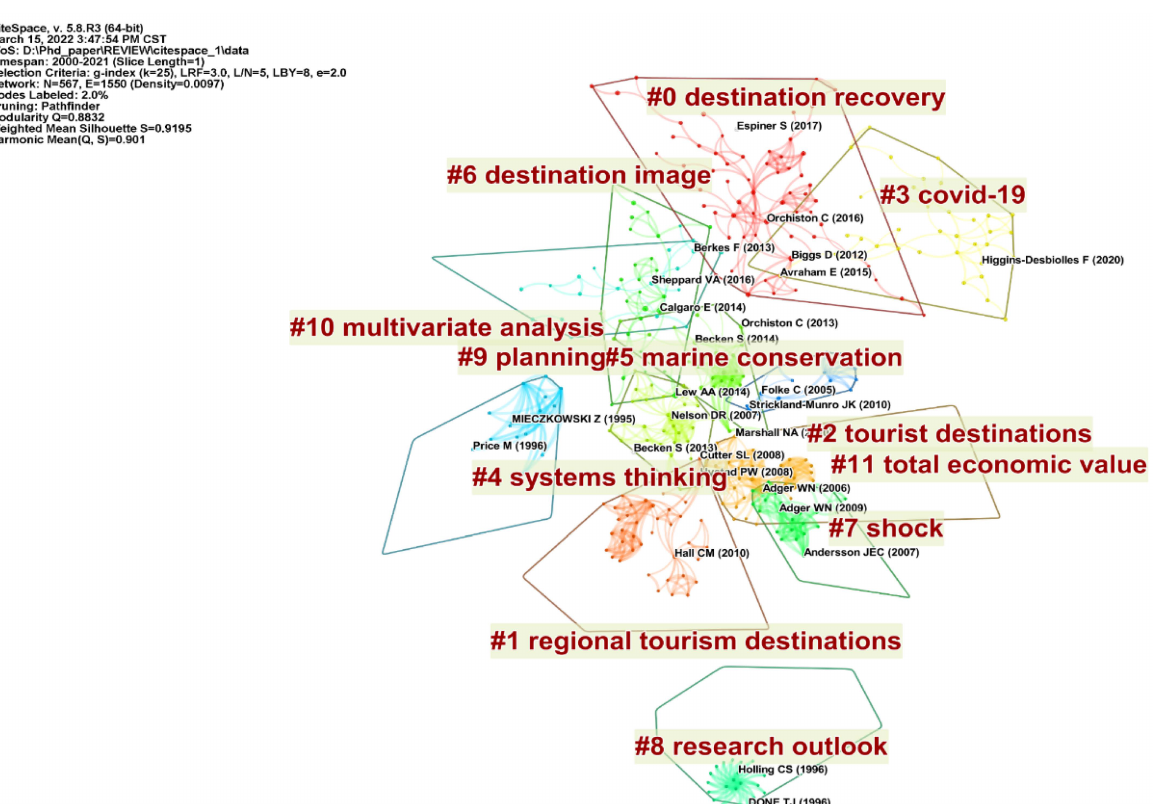
Figure 3. Clustering network of literature